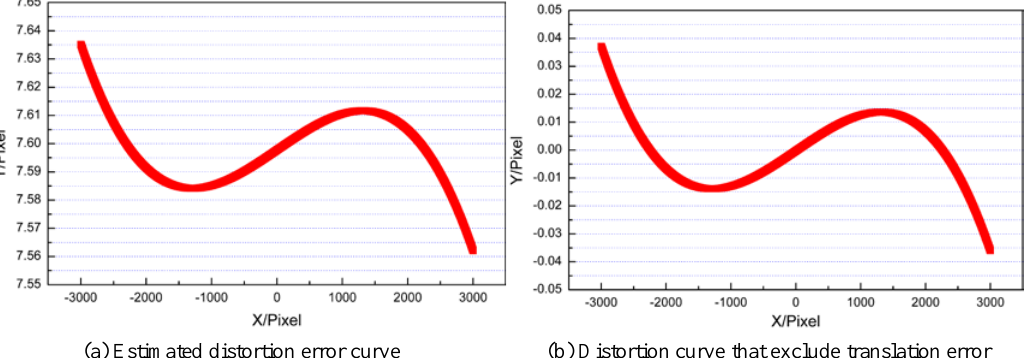
Figure 7. The distortion curves of estimated internal